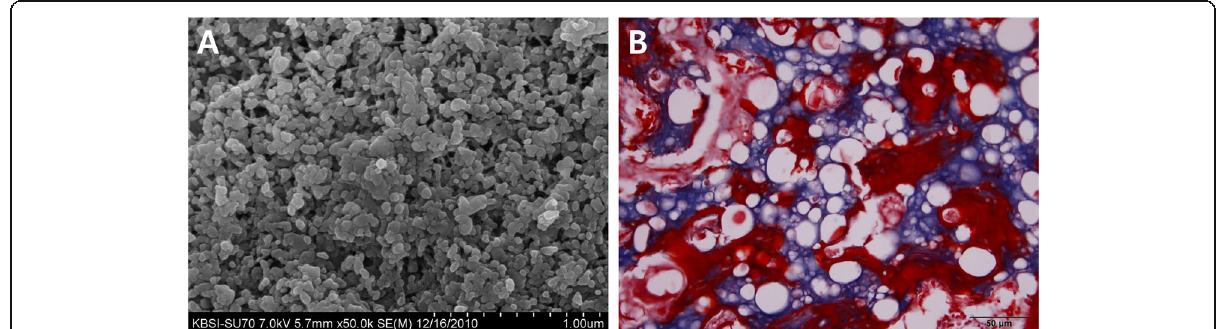
Fig. 2 Hydroxyapatite (HA) as a bone graft. A Scanning microscopic image of HA crystal. B HA has been grafted into the rabbit ’ s calvarial defect. New bone formation is observed around the vacant spots at 8 weeks postoperatively. Vacant spots are occupied by HA and dissolved during